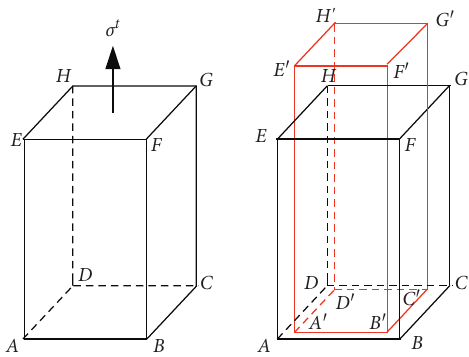
Figure 3: Cubic specimen under uniaxial tensile